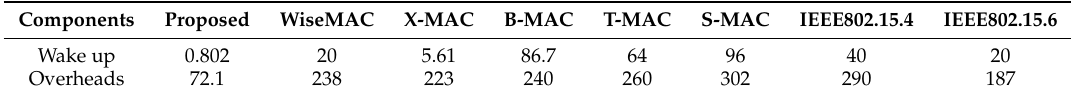
Table 7. Break down of wake up time and overhead time (units are in